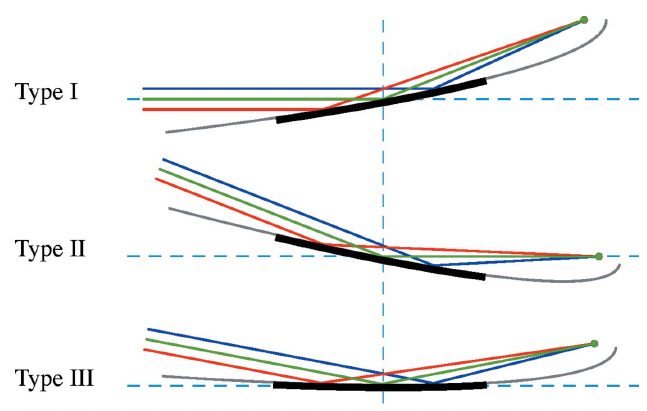
Figure 2 Three congruent descriptions of a concave, tangentially parabolic mirror geometry shown as a cross-section in the meridional plane ( x = 0). The mirror is used to focus a collimated beam, or to collimate a divergent beam in one direction. The mirror (thick line) is a section of a parent parabolic curve (gray